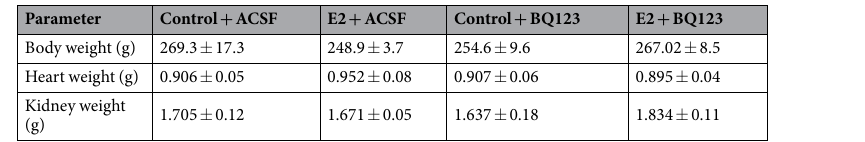
Table 2. Body weight, heart and kidney weight in animals that were sham-implanted or implanted with E2 pellets and infused with ACSF or BQ123